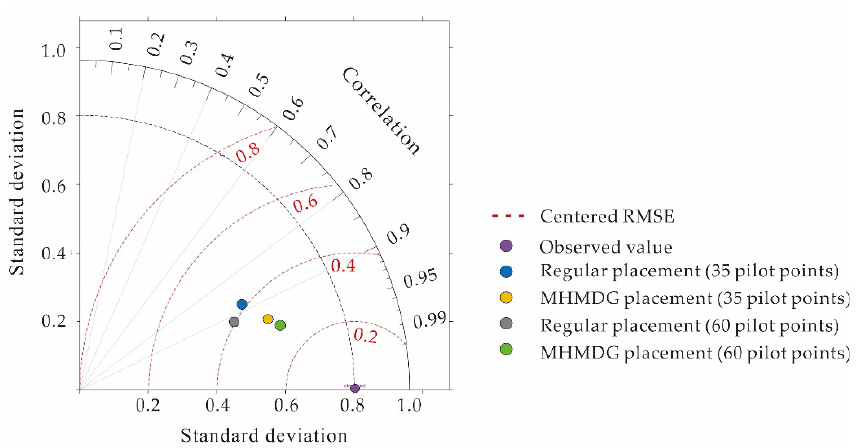
Figure 9. Taylor diagram of the comparison between the observed head and the calculated